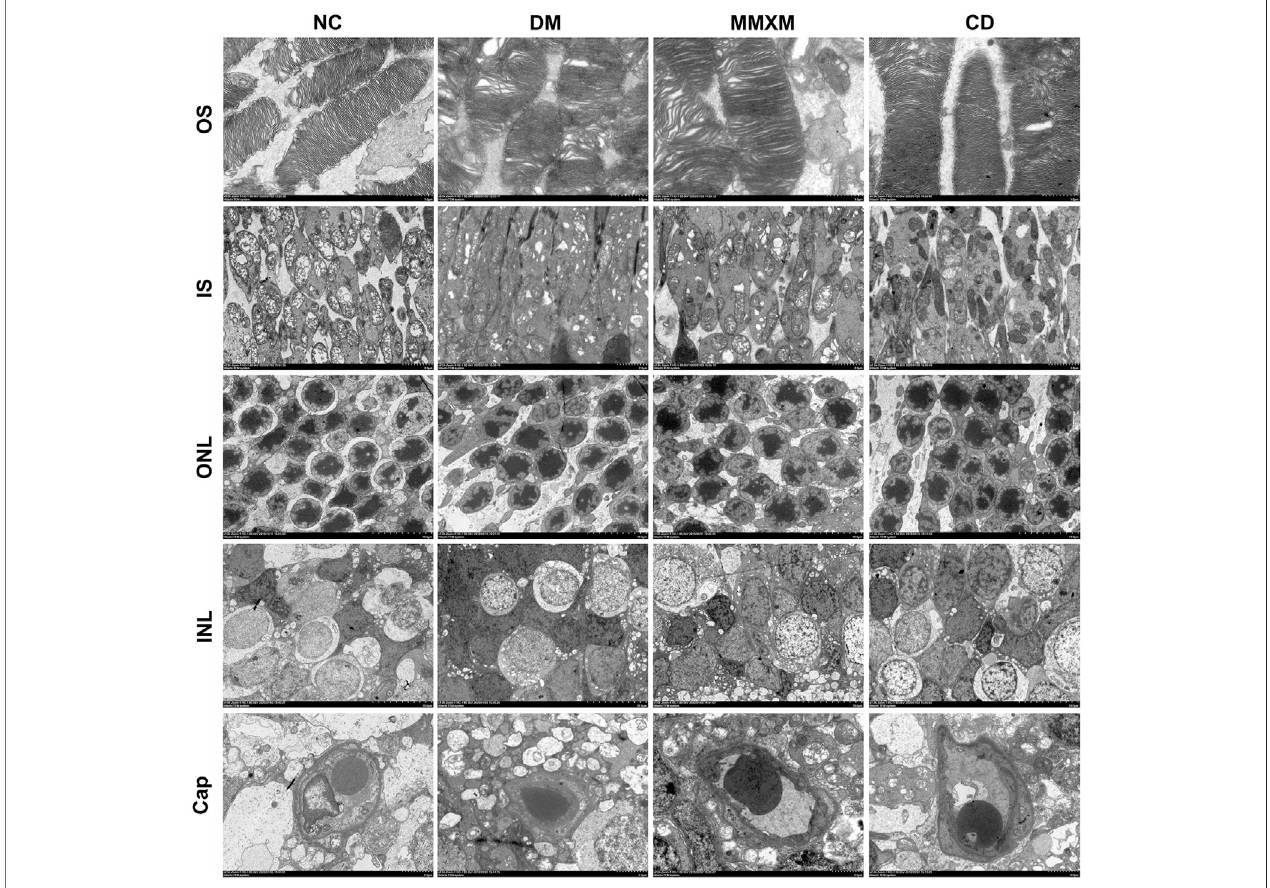
FIGURE6| Retinalcellultrastructure.OS:outersegment,Originalmagni fi cation6,000 × ;IS:innersegment,originalmagni fi cation2,500 × ;ONL:outernuclearlayer, original magni fi cation 1,000 × ; INL: inner nuclear layer, original magni fi cation 1,000 × ; Cap: capillary, original magni fi cation 2,500 × .